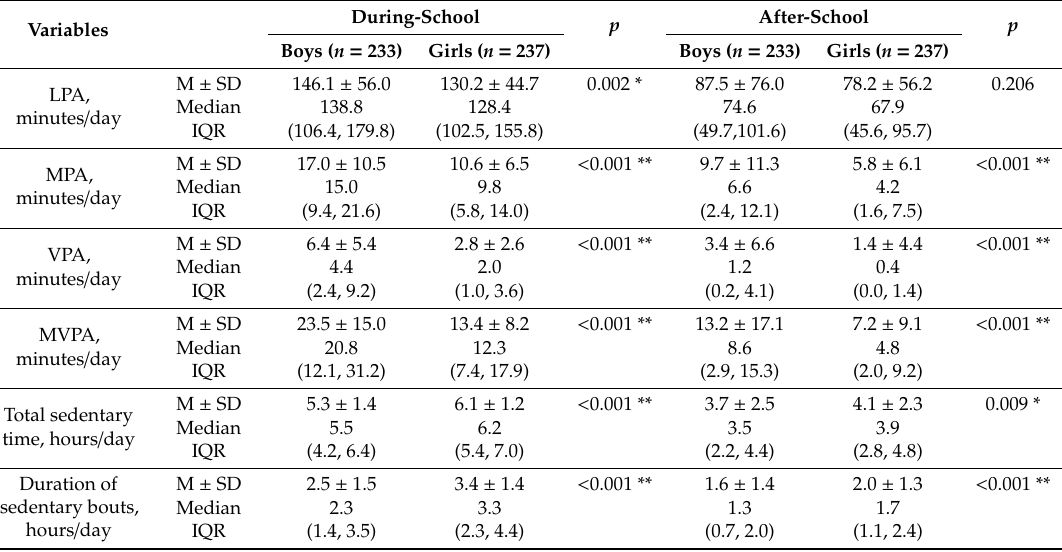
Table 4. Time spent in objectively measured PA and SB patterns in adolescents during-school and